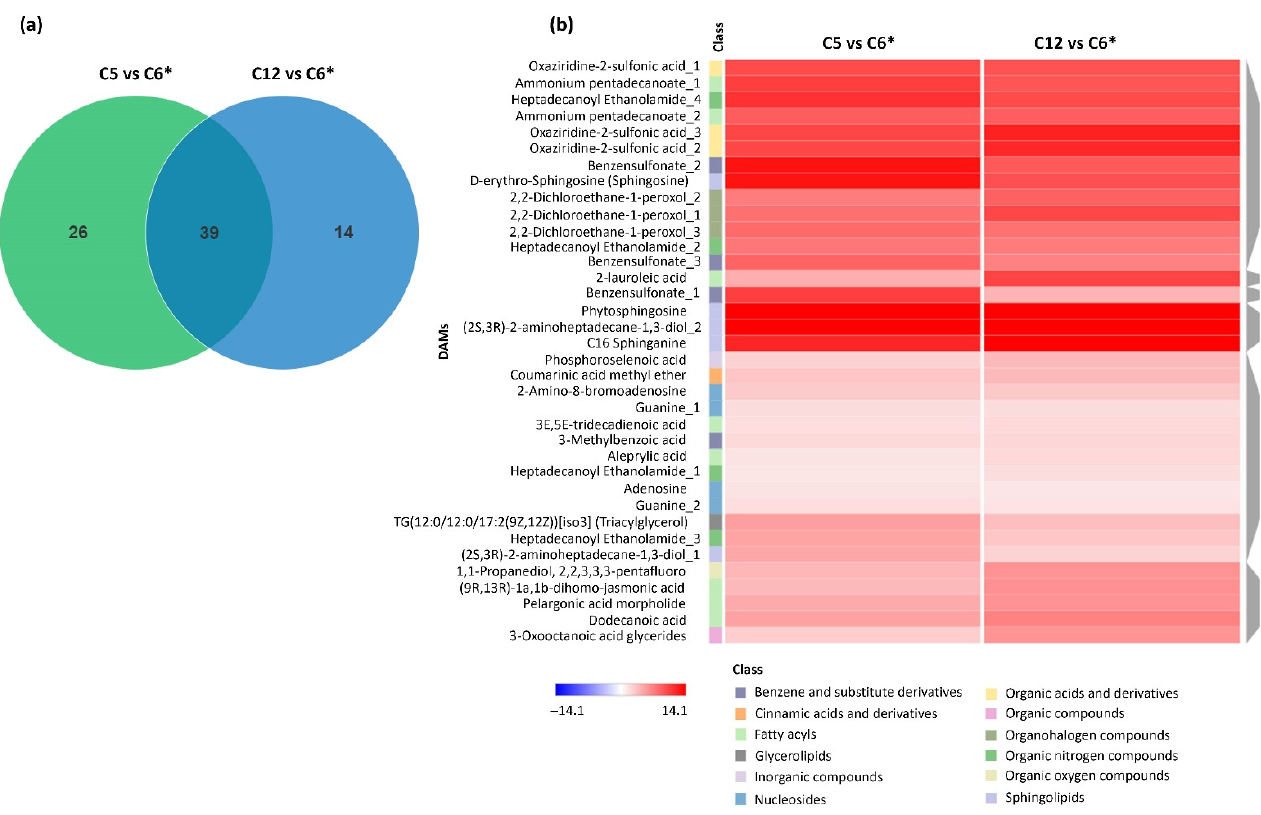
Figure 3. The distribution of significant DAMs in the C. militaris cultures as pairwise comparisons between the C5 vs. C6 cultures and C12 vs. C6 cultures ( a ). Venn diagram shows a number of common DAMs across pairwise comparison sets ( b ). A heat map diagram shows patterns of DAMs as pairwise comparisons together with the identified metabolites and relevant compound classes. Each of DAMs is colored by log 2 fold change value. The asterisk (*) means the reference carbon source used for all possible pairwise comparisons.